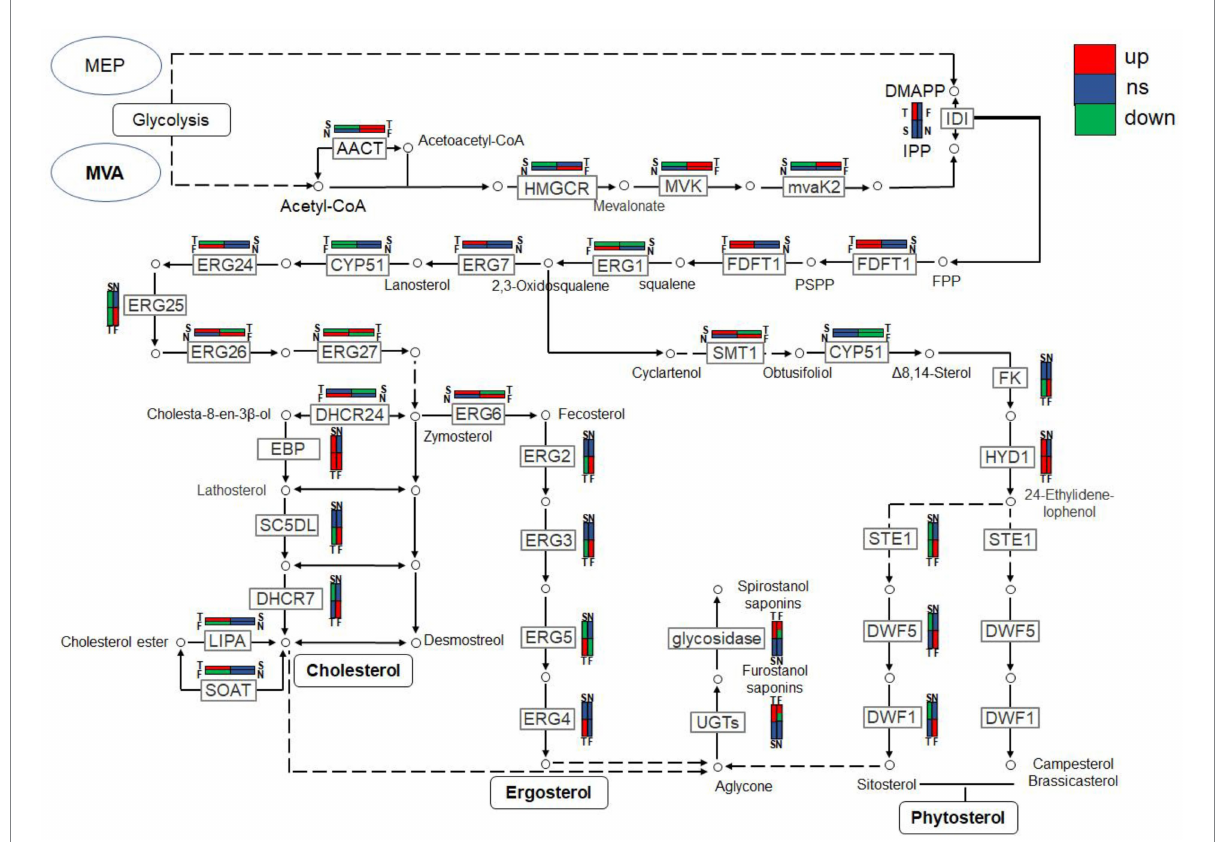
FIGURE 12 The expression trends of genes related to steroidal saponin synthesis pathway in fermentation on days 3(T), 5(F), 7(S), and